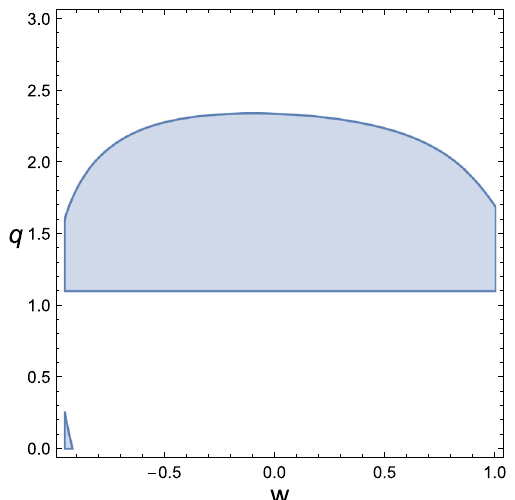
Fig. 1 Region plot for the state parameter w and the power-law param- eter q forthemodeldescribedby(95)with C 5 = 0.Thefigurerepresents the regions where the point (106) is stable. The blank regions represent the regions where the point is a saddle one